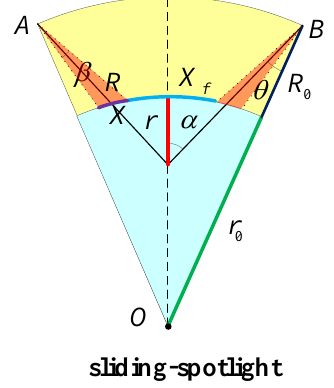
Figure 1. Space-borne sliding-spotlight mode planar imaging curved Earth geometry. A and B are the orbit start and end. The orange region represents the beam. The blue region represents the Earth’s interior.